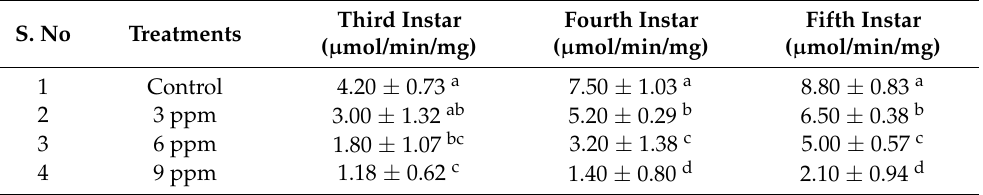
Table 1. Effect of andrographolide on digestive enzyme amylase of S. litura.